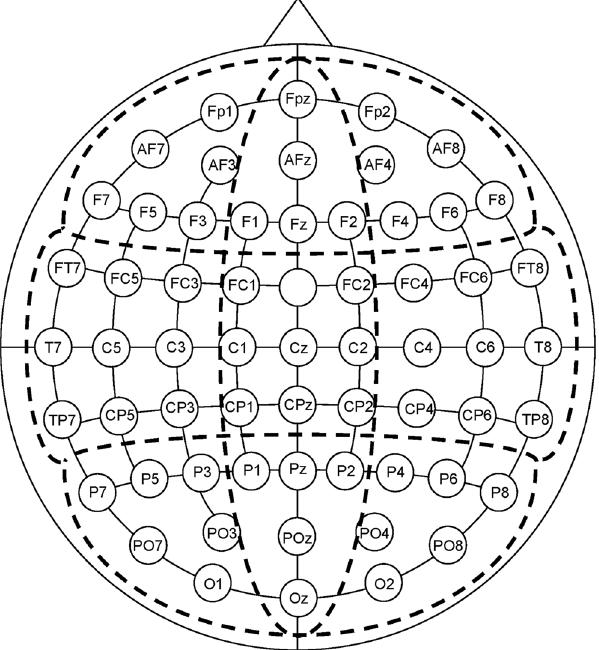
Figure 2. Layout of the nine electrode pools. Sagittal line: anterior (a), central (c), posterior (p); transversal line: left (l), midline (m), right (r); sagittal by transversal: al: Fp1, AF7, AF3, F7, F5, F3; am: FPz, AFz, F1, Fz, F2; ar: Fp2, AF4, AF8, F4, F6, F8; cl: FT7, FC5, FC3, T7, C5, C3, TP7, CP5, CP3; cm: FC1, FC2, C1, Cz, C2, CP1, CPz, CP2; cr: FC4, FC6, FT8, C4, C6, T8, CP4, CP6, TP8; pl: P7, P5, P3, PO7, PO3, O1; pm: P1, Pz, P2, POz, Oz; pr: P4, P6, P8, PO4, PO8, O2. The ground electrode was placed at